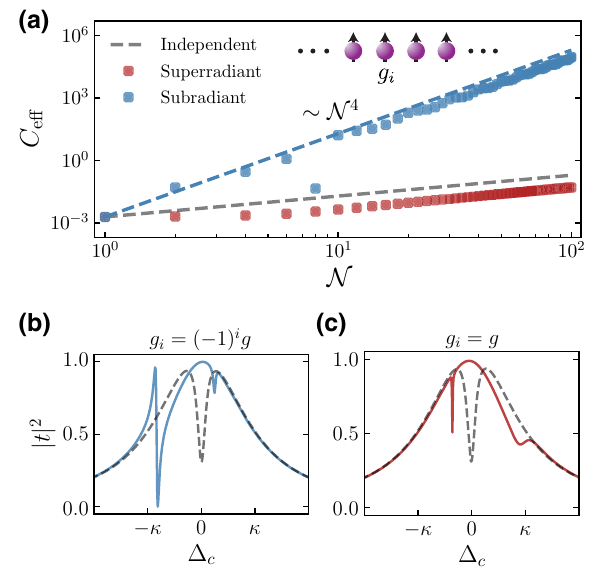
FIG. 11. (a) Effective cooperativity C eff of a cavity-embedded chain of emitters as a function of N for the superradiant (red, symmetric addressing g i = g ) and subradiant [blue, antisym- metric addressing g i = ( − 1 ) i g ] case. Parameters: a = 0.1 λ , γ = κ/ 20, g = κ/ 100. The bottom half shows the cavity transmission functions for (b) antisymmetric and (c) symmetric excitation of four equally spaced emitters for a = 0.08 λ , g = κ/ 10. The gray dashed curves shows the result for independent emitters. In all plots, the dipole moments are chosen perpendicular to the